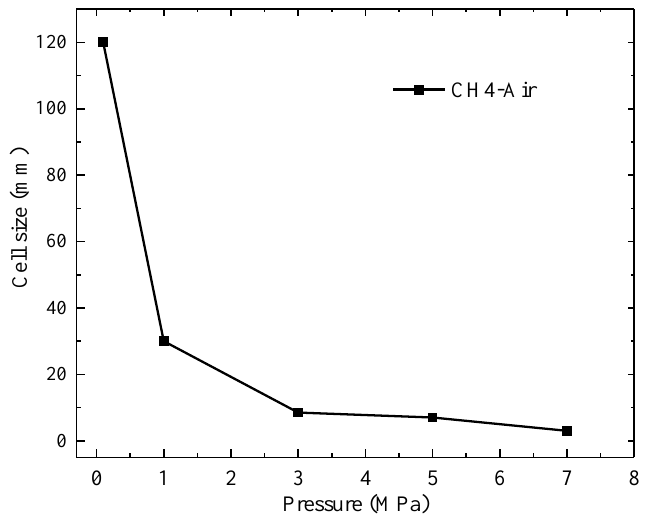
Figure 5. The relationship between detonation cell size and initial pressure provided by Purdue [49].